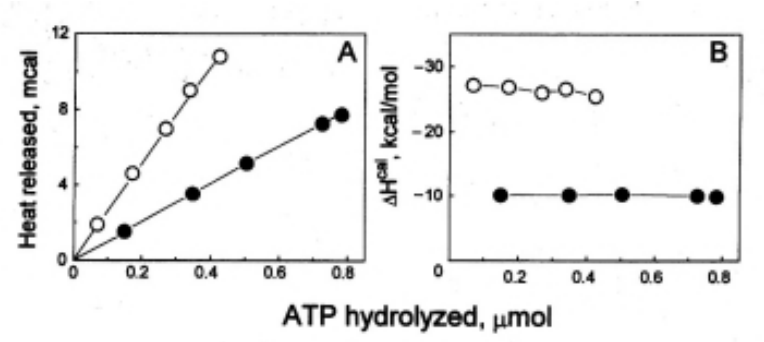
Fig. 1 – Heat release duringATP hydrolysis in presence and absence of a transmembrane Ca 2 + gradient. The assay medium and experimental conditions were as in Table I using ( ❍ ) intact vesicles that accumulated Ca 2 + and formed a transmembrane Ca 2 + -gradient and ( (cid:2) ) leaky vesicles which were not able to retain Ca 2 + inside the vesicles. The figure shows a typical experiment where the amount of heat released (A) and the (cid:5)H cal values (B) were plotted as a function of at the amount of ATP cleaved at different incubation intervals. The calorimetric enthalpy ( (cid:5)H cal ) was calculated by dividing the amount of heat released by the amount of ATP cleaved by the vesicles. Note that when more negative the values of (cid:5)H cal , more heat was released during the hydrolysis of ATP. For experimental details see de Meis et al.